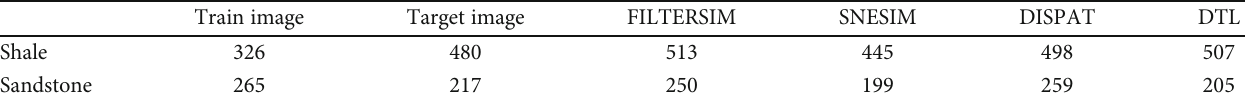
Table 5: The average numbers of pores in the TIs, the target images, and 10 reconstructed images using FILTERSIM, SNESIM, DISPAT, and DTL.